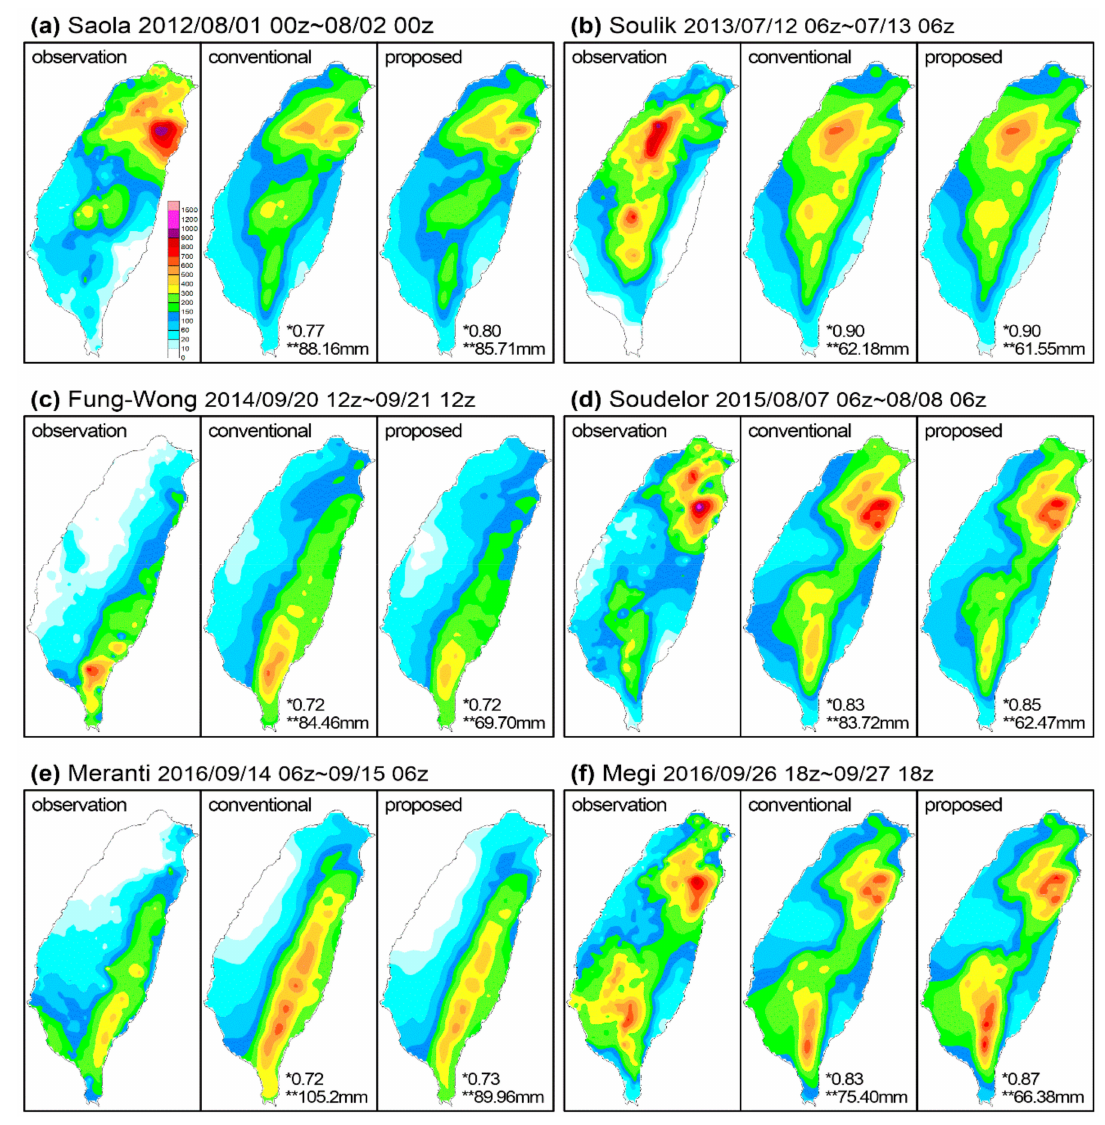
Figure 7. Observed and forecasted 24 h rainfall from the conventional and the proposed methodologies of 6 typhoons: ( a ) Saola; ( b ) Soulik; ( c ) Fung-Wong; ( d ) Soudelor; ( e ) Meranti; and ( f ) Megi (* and ** are the CC and RMSE values,